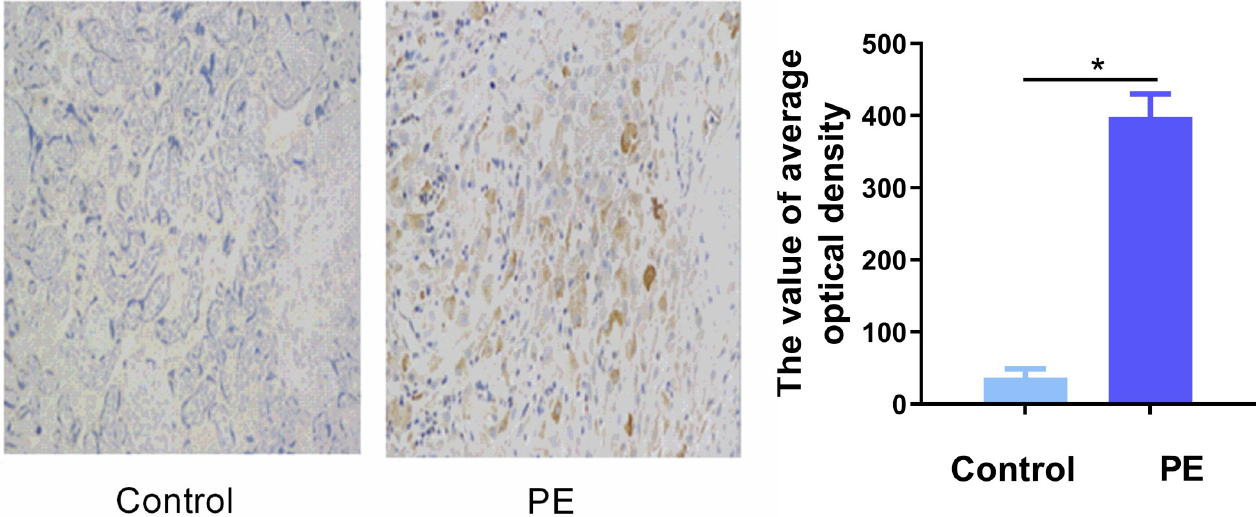
Fig 3. SerpinA5 immunohistochemistry. The PE group (n = 10) exhibited strong SerpinA5 staining (average optical density (IOD [mean]) in the placenta compared with that of the control group (n = 10) (DAB, brown, Mann–Whitney U test).